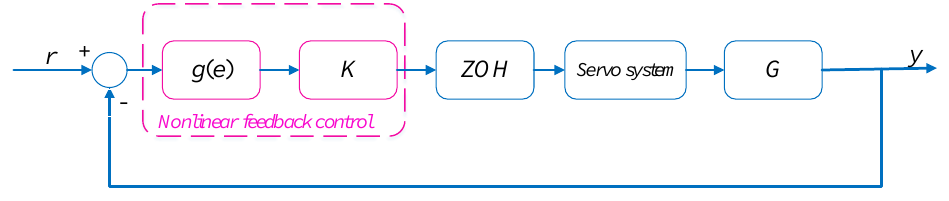
Figure 8. Block diagram of rudder roll damping system.